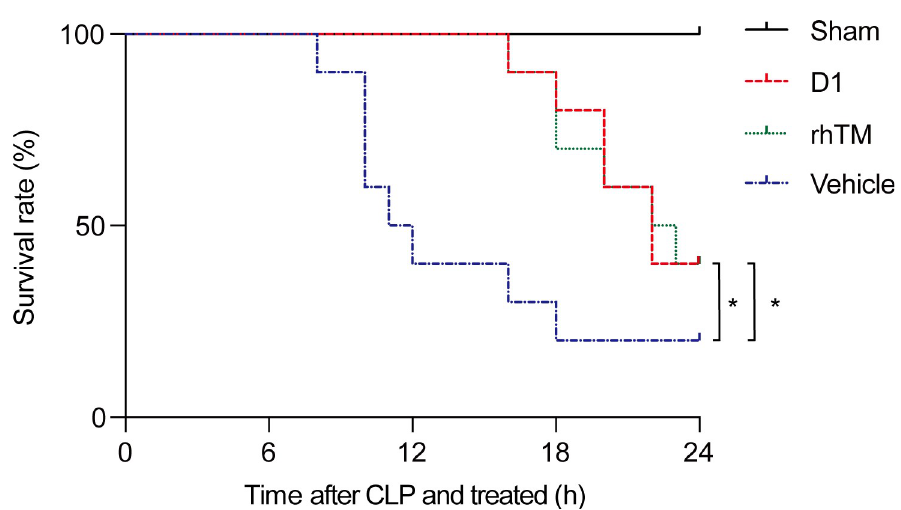
Fig 8. Survival curves in rats after CLP procedure. Rats were administered either: rhTM (green dotted line); D1 (red dashed line); or saline as a vehicle (blue dashed dotted line). Sham rats are represented by the black solid line. n = 10 per group. � P < 0.05 vs.